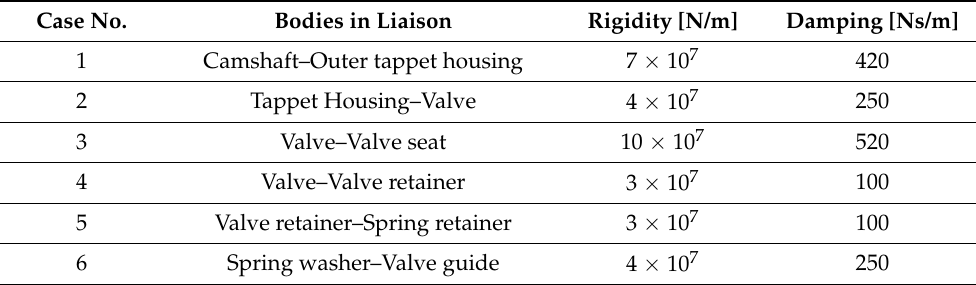
Table 2. Coefficients of rigidity and damping.